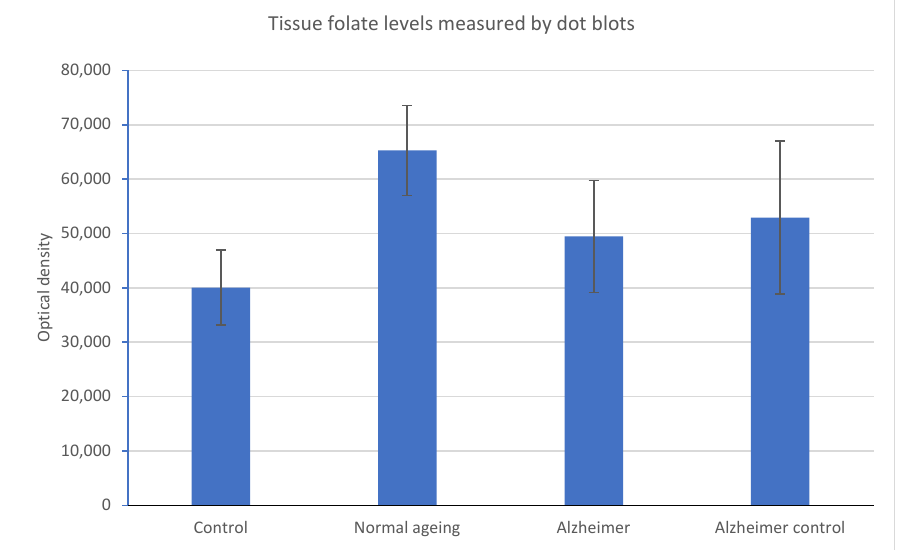
Figure 2. Comparison of negative and positive gene SNPs on tissue folate levels in the groups used in the study metabolic profiles. Folate levels were not significantly different between controls and other groups with and without mutant SNPs in MTHFD1 and/or MTHFR. The controls have a lower level of folate than the other groups, although this is not significant.